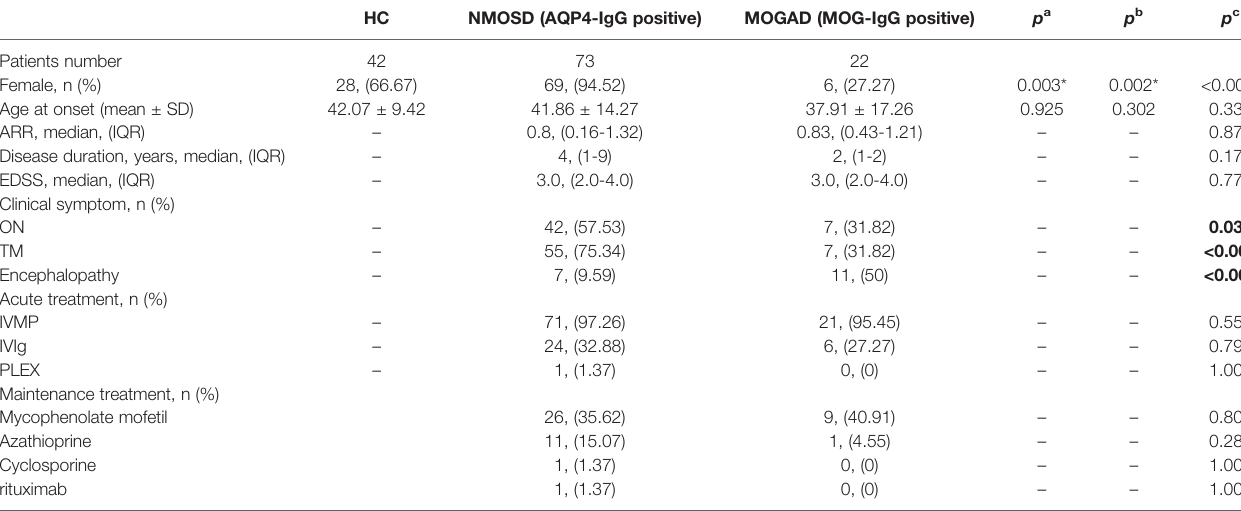
TABLE 1 | The detailed fi ndings of Demographic, clinical features, and treatment in NMOSD and MOGAD patients.